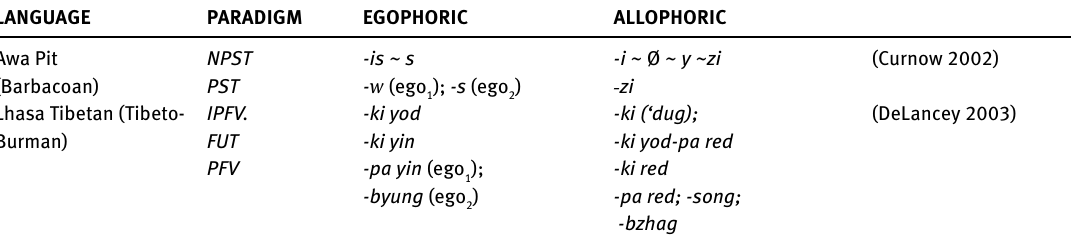
Table 2 . Paradigms of complex egophoric marking systems in Awa Pit and Lhasa Tibetan